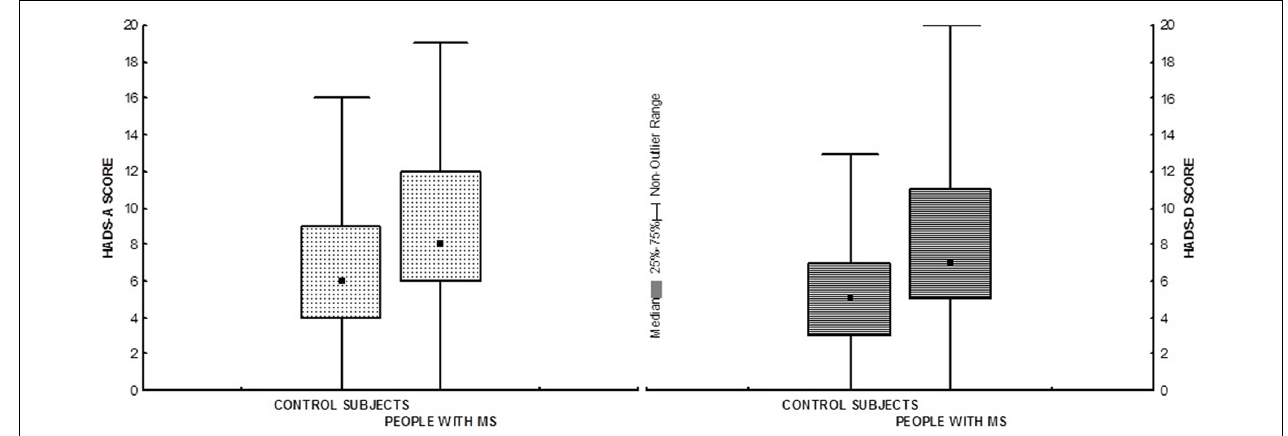
FIGURE 2 | Box plots showing medians and interquartile range of HADS scores in pwMS and control subjects. HADS-A, HADS Anxiety subscale; HADS-D, HADS Depression subscale.